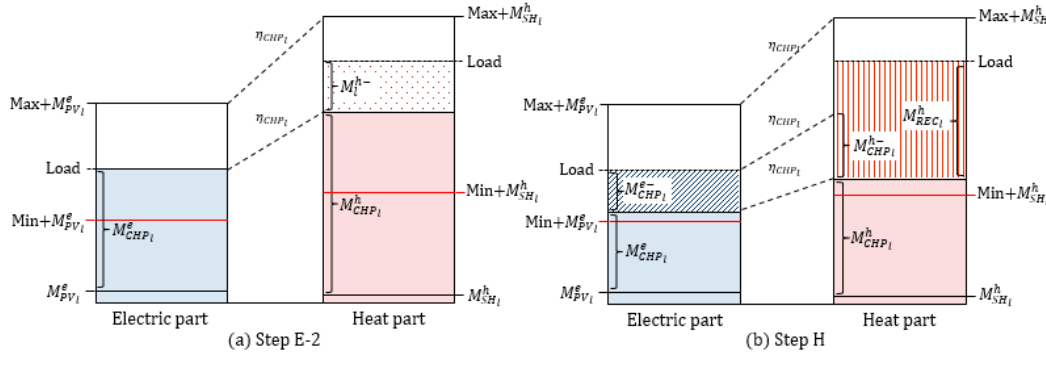
Figure B3. Example ‐ 3 when ∑